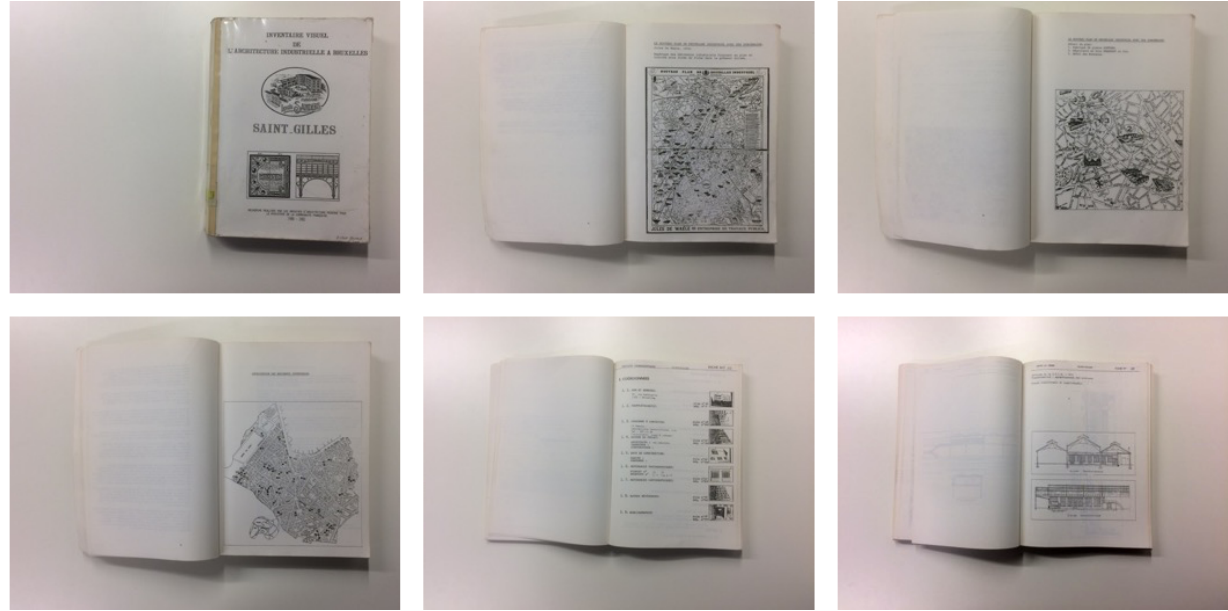
Figure 2. Inventaire Visuel . From the Bibliothèque Générale des Sciences Humaines (BGSH, UCLouvain). Photograph by the